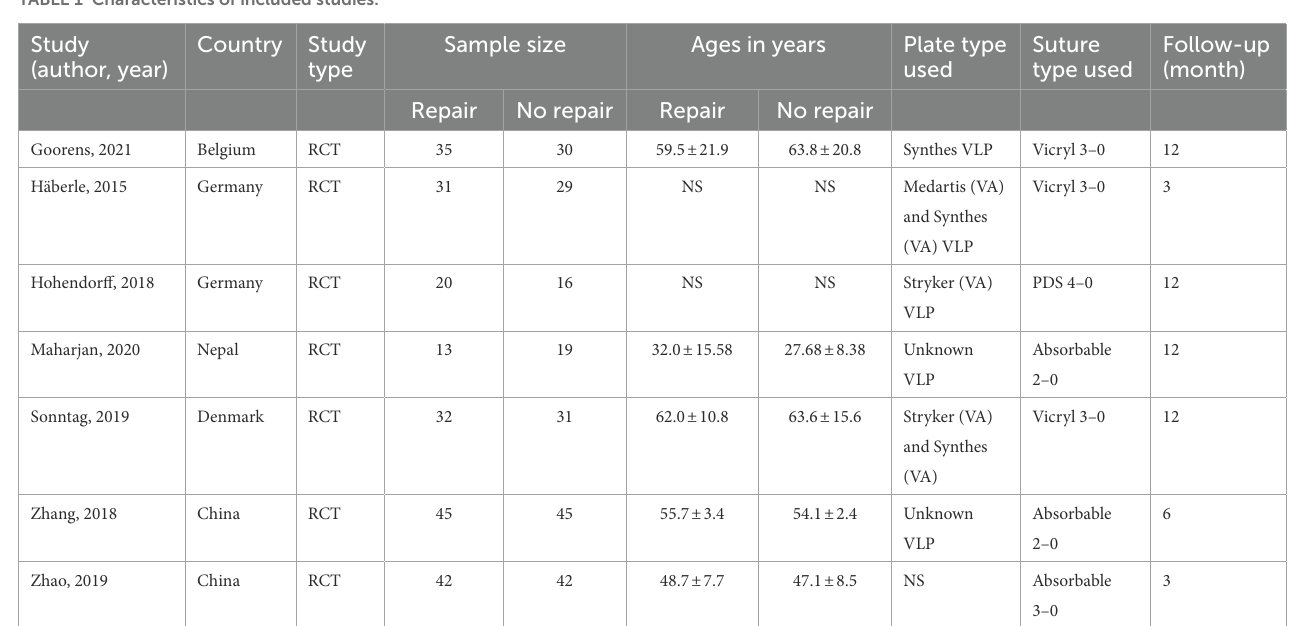
TABLE 1 Characteristics of included